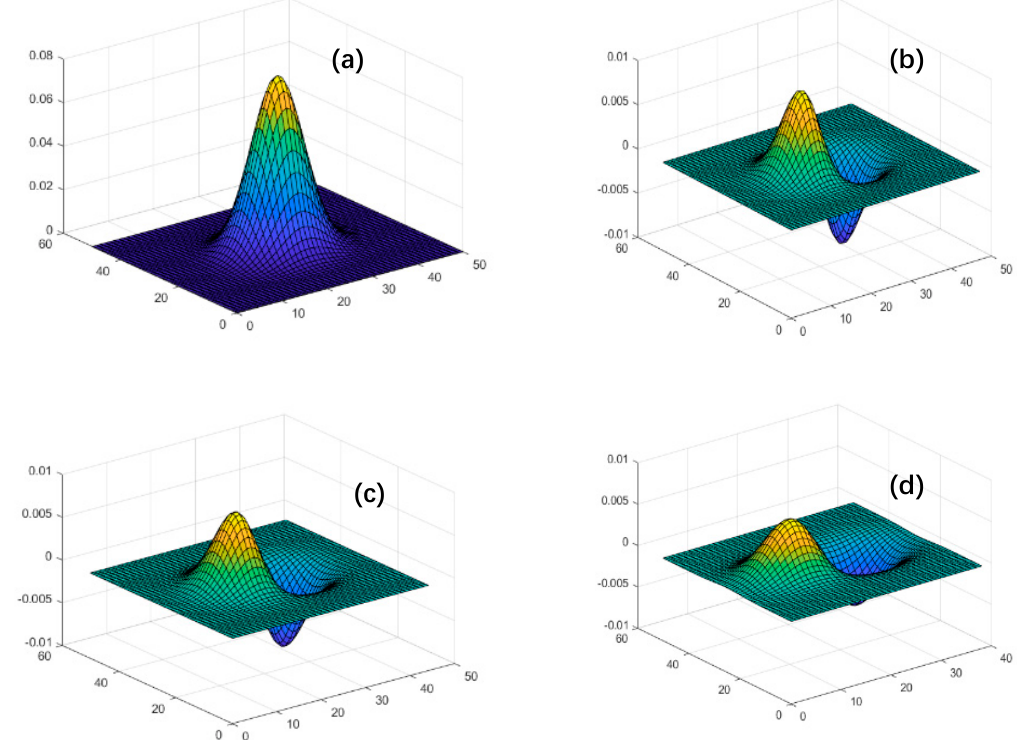
Figure 3. The simulation of difference distribution in various shearing distance: ( a ) Gaussian function, ( b ) ∆ x = 3, ( c ) ∆ x = 6, and ( d ) ∆ x = 12. Without loss of generality in conclusion, the units are omitted.